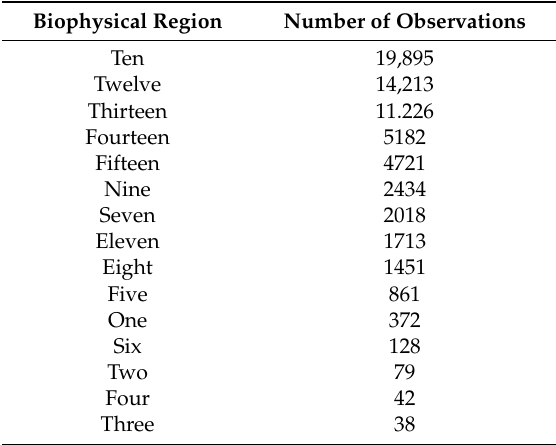
Table 1. Observations by Biophysical Region.